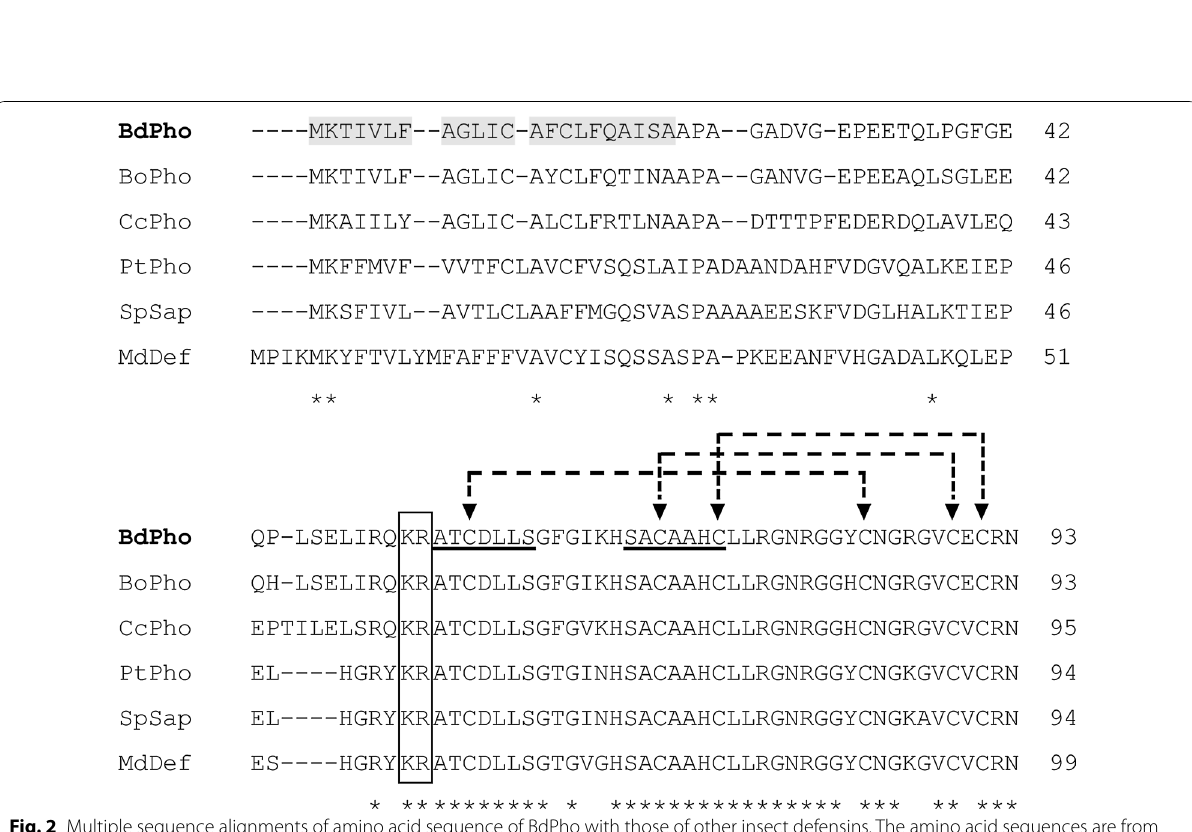
Fig. 2 Multiple sequence alignments of amino acid sequence of BdPho with those of other insect defensins. The amino acid sequences are from B. dorsalis (BdPho, KY038166), B. oleae (BoPho, XP_014095033); Ceratitis capitata (CcPho, XP_004537627); Protophormia terraenovae (PtPho, P10891); Sarcophaga peregrina (SpSap, AAA29984), and Musca domestica (MdDef, AIL24687). The signal peptide of BdPho is on a gray background. The conserved mature peptide cleavage sites “‑KR‑” are boxed, and amino acids corresponding to predicted α‑helix are underlined. Identical residues are indicated by * under the residues. The triangles indicate the six conserved cysteine residues and the dashed lines indicate the disulfide